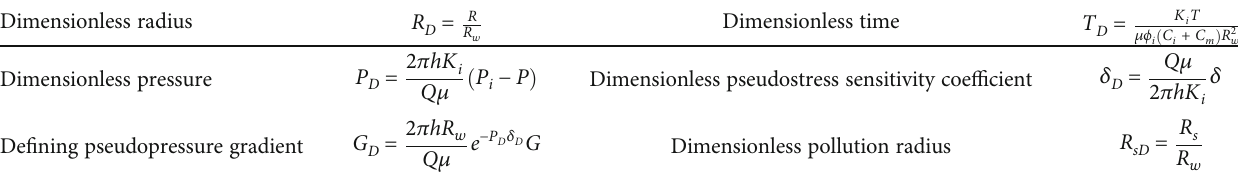
Table 2: Dimensionless de fi